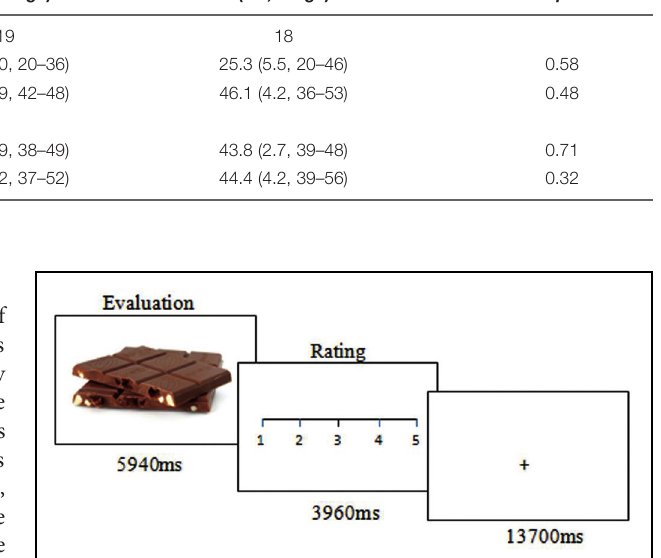
FIGURE 1 | Experimental task. The trials started with displaying a food photograph for nearly 6 s while the participants evaluated the healthiness of the food item. This was followed by a rating period of nearly 4 s. A baseline condition of nearly 16 s was implemented between